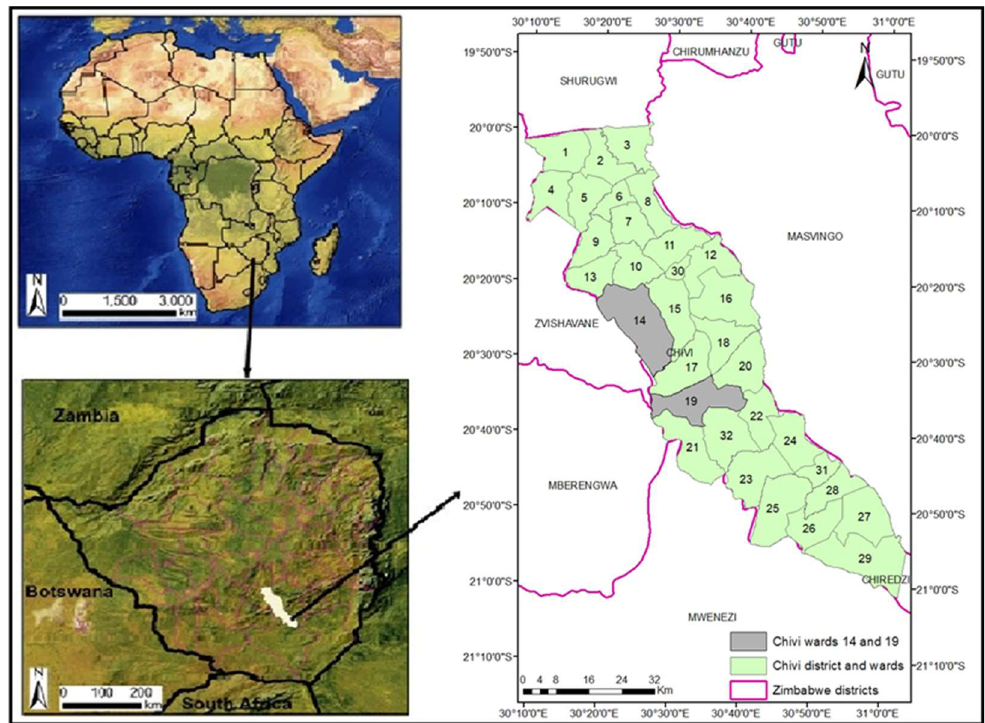
Figure 1. Wards 14 and 19 in the Chivi district in Zimbabwe. The background image is the natural earth-shaded relief layer for Africa and Zimbabwe, respectively.